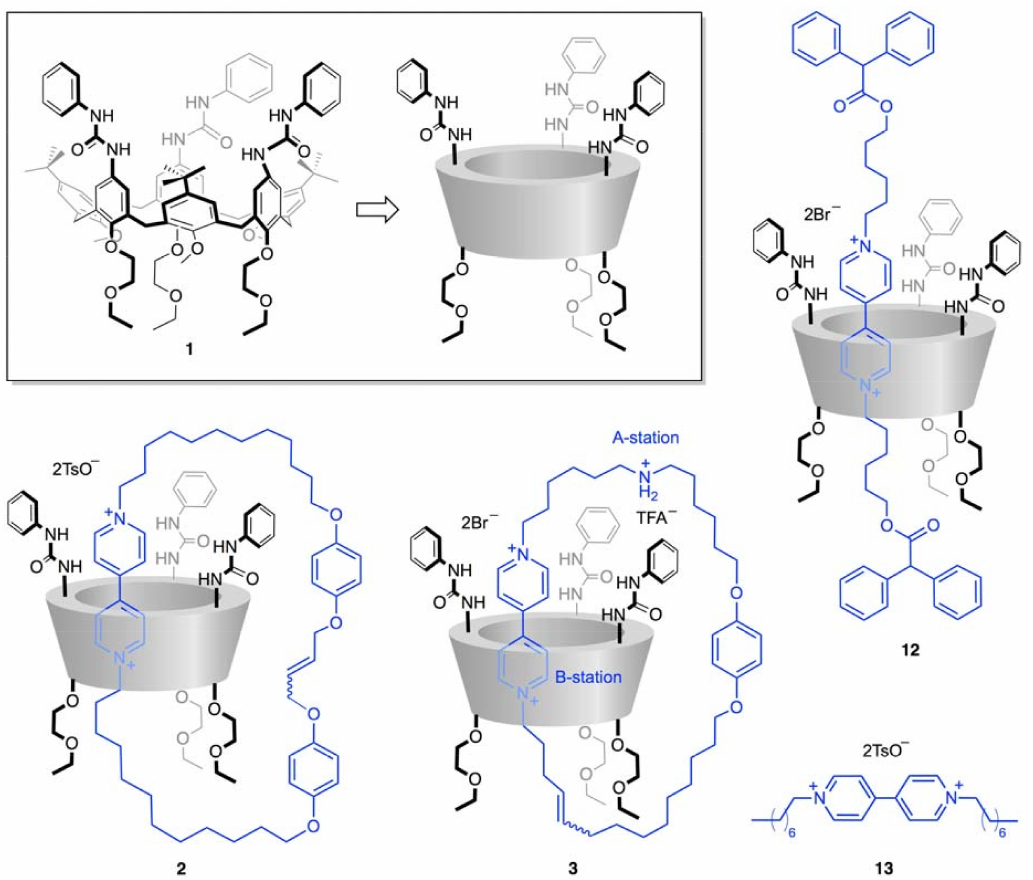
Figure 2. Structural formula of the investigated compounds and model species: the tris( N - phenylureido)calix[6]arene-based wheel 1 and its cartoon representation, the one-station [2]catenane 2 , the two-station oriented [2]catenane 3 , the [2]rotaxane 12 , and the bipyridinium-based axle 13